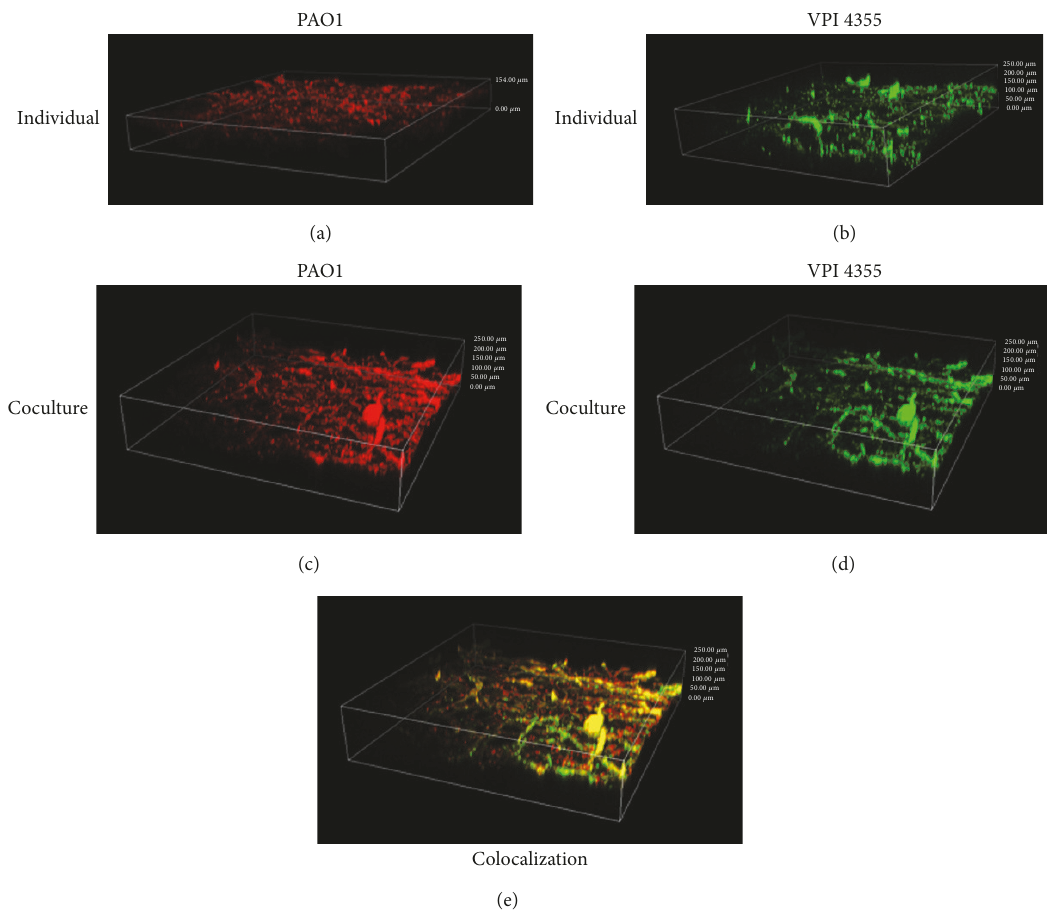
Figure 8: F. nucleatum and P. aeruginosa coaggregate within the dual-species biofilm. Biofilms of PAO1, VPI 4355, or both were inoculated into BHI broth containing cellulose disks as described in Figure 2. After 24 h, the disks were removed, rinsed, stained by fluorescence in situ hybridization, and examined by confocal laser scanning microscopy. (a) PAO1 alone grown aerobically (red). (b) VPI 4355 alone grown anaerobically(green).(c)PAO1indual-speciesbiofilmgrownaerobically(red).(d)VPI4355indual-speciesbiofilmgrownaerobically(green). (e) Coaggregation of PAO1 and VPI 4355 in dual-species biofilm grown aerobically is indicated by colocalization of red and green stains (yellow). Representative images are shown at 400x